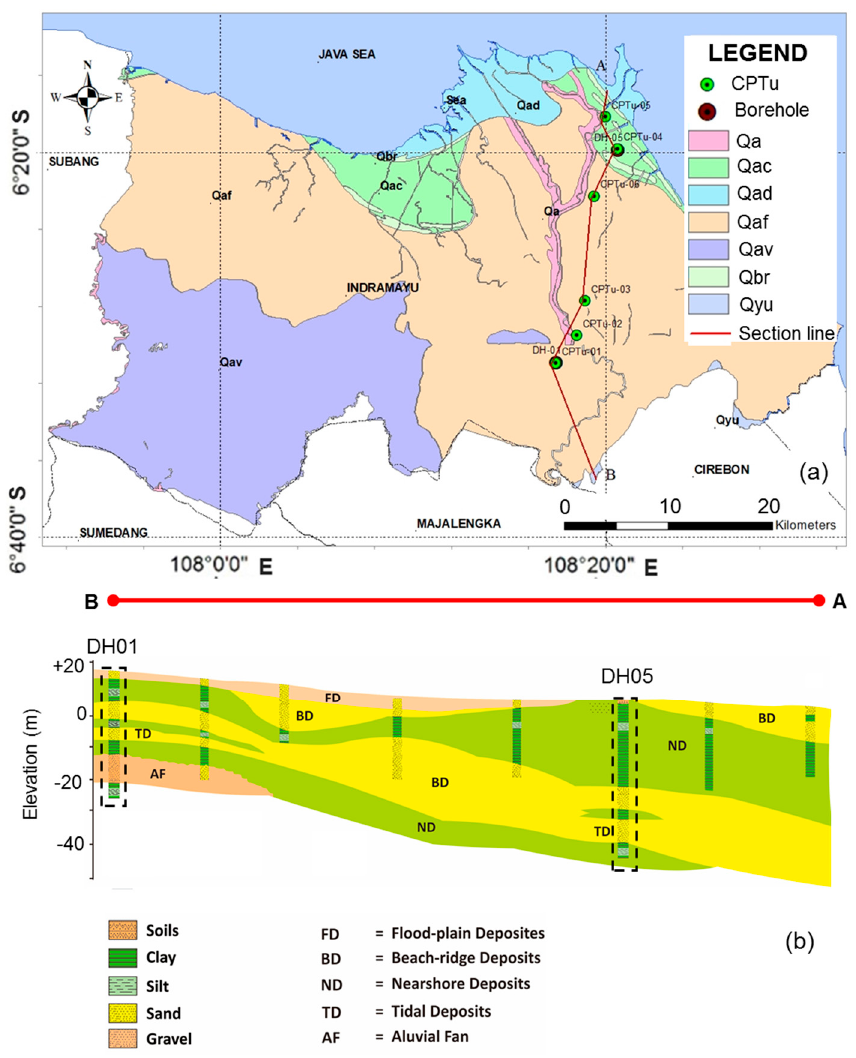
Figure 3. Geology ( a ) and vertical profile in the B–A cross section ( b ) of Indramayu, Indonesia (Completely redrawn and modified after Maria et al. 2018 [29]).